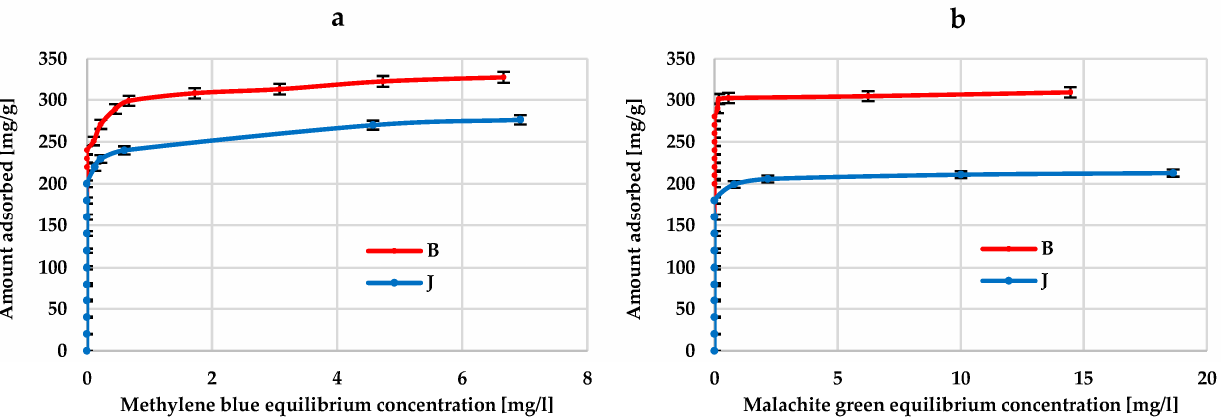
Figure 6. The effectiveness of methylene blue ( a ) and malachite green ( b ) removal from the aqueous solutions.